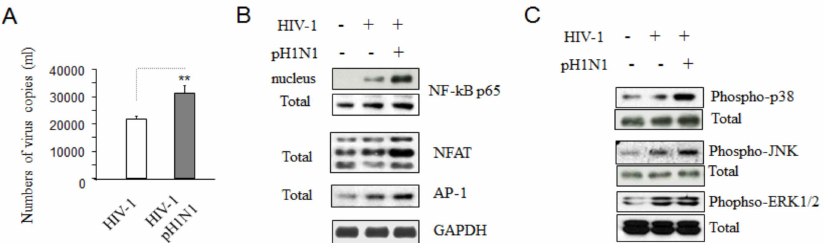
Figure 3. Pandemic influenza A (H1N1) virus infection can activate more HIV RNA production through increased activities of some host transcript factors in HIV-1 infected cells. Jurkat cells were infected with HIV-1 (MN) for 3 days, and then infected with pH1N1, stock A/California/04/2009, and cultured for 3 days. ( A ) 140 µ L of culture supernatants containing HIV-1 particules were used to isolate viral RNA. 10 µ L in 50 µ L of the RNA was used as template to perform real-time PCR. Known concentrations if HIV-1 (MN) viral RNA (serially diluted: 10 8 to 100 copies) were used as template and quantitative RT-PCR performed to generate a standard curve. Each value represents the average concentration of six reactions in triple isolated repeats based on the standard curve. The cell lysates were subjected to Western blot analysis to detect NF- κ B p65, NFAT, AP-1 ( B ) and p38, JNK, ERK1/2 ( C ) with GAPDH as the